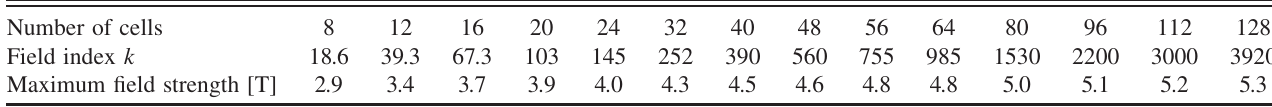
TABLE I. Number of cells and field index k which give the cell tune of (0.75, 0.25). Maximum field strength is also shown for a particle momentum of 1 GeV =c with a reference orbit radius of 10 m. Number of cells